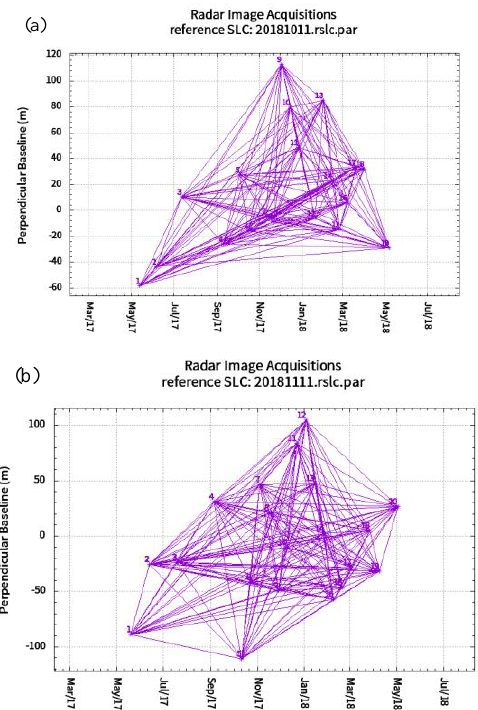
Figure 2. Temporal-spatial baseline distributions of the Sentinel-1A image stacks in this study. (a) Track 40. (b) Track 142.